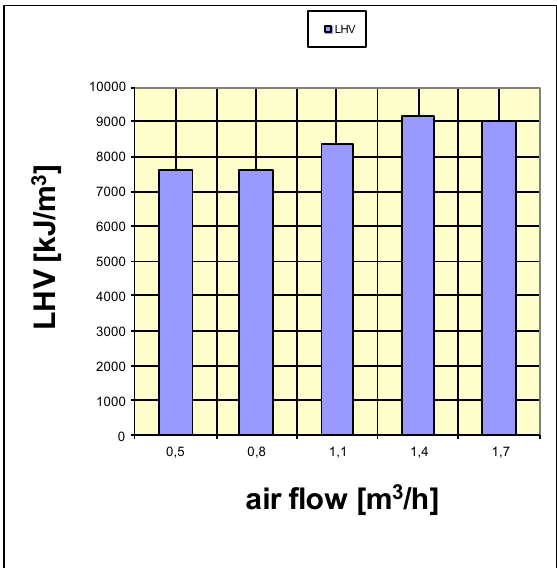
Fig. 2. The calorific value of the syngas, characteristic for different gas streams.